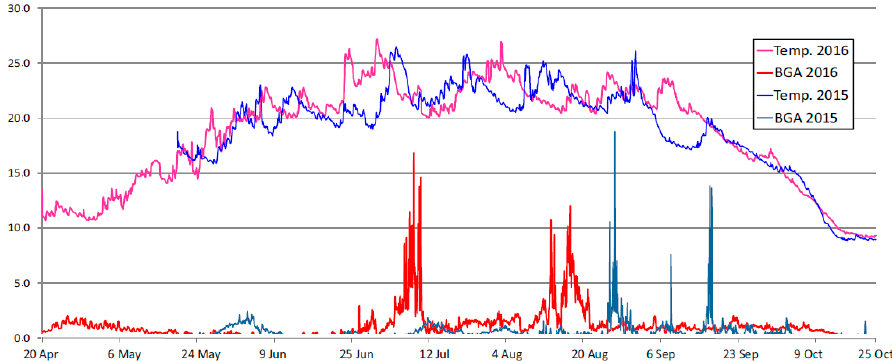
Figure 7. Diagram of changes in the water temperature and blue-green algae (BGA) concentration in the north part of the Sulejow Reservoir, in both analysed seasons (BGA concentration ( µ g/dm 3 ); water temperature ( ° C).